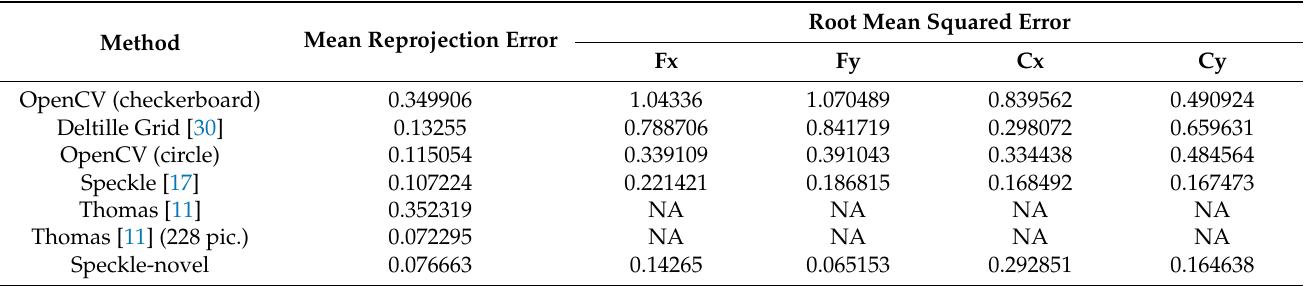
Table 2. Reprojection error and RMSE of internal parameters’ estimation of different calibration methods, with a training set of 228 images for method of line 6, and 20 images for other methods.